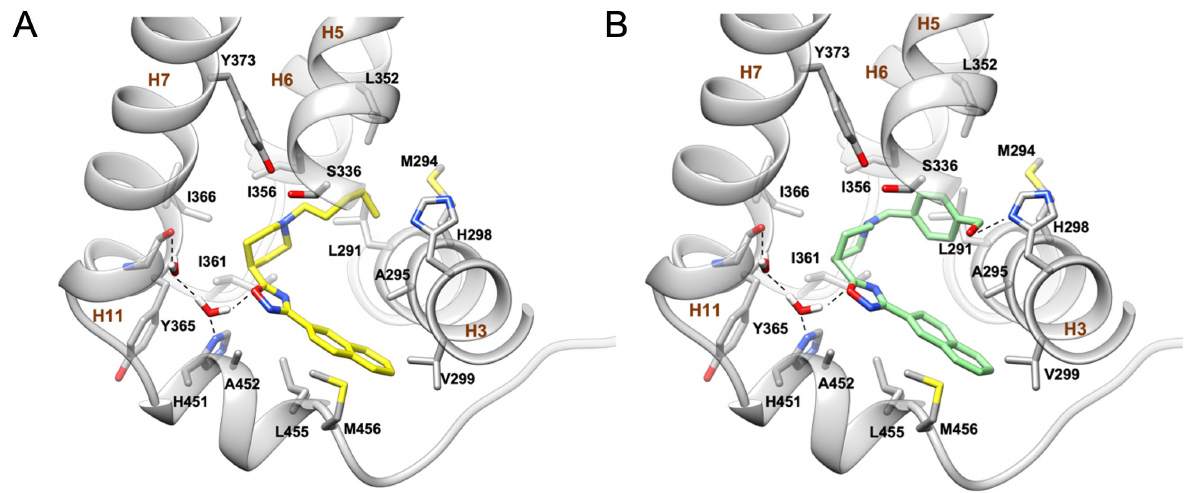
Figure 4. Binding modes of ( A ) compound 5 (in yellow sticks) and ( B ) compound 11 (in light green sticks) in the X-ray structure of FXR-LBD (PDB ID 4OIV) [35]. FXR is shown as a gray cartoon, while the interacting residues of the receptors are shown as gray sticks. Hydrogens are omitted for clarity. Hydrogen bonds are shown as dashed black lines. The bridging water molecules are reported as red sticks with explicit hydrogens.